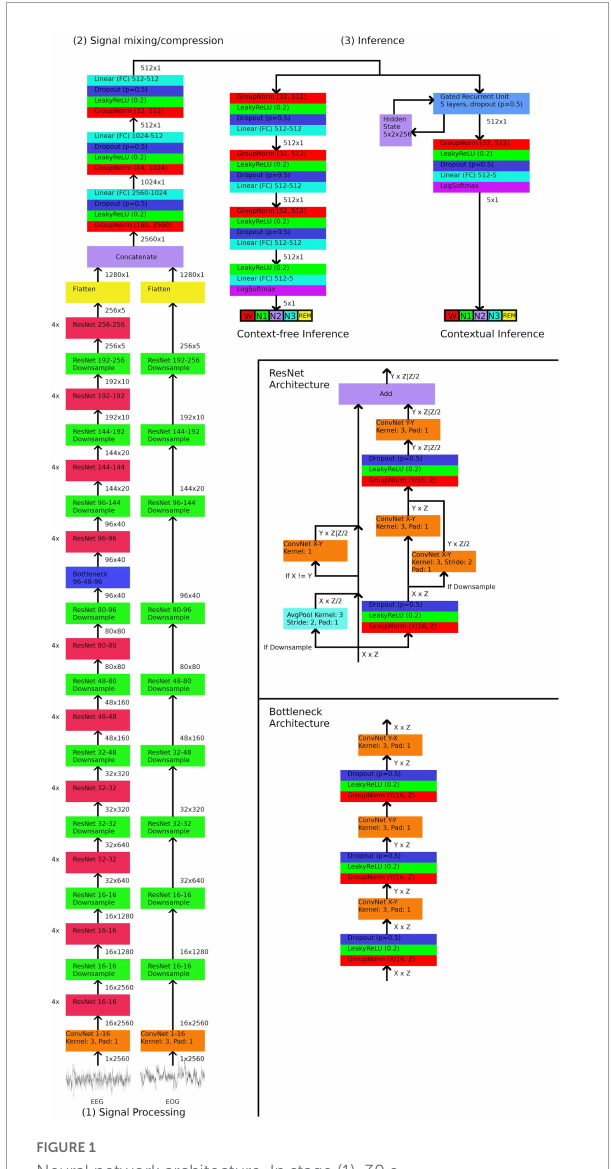
FIGURE1 Neural network architecture. In stage (1), 30 s electroencephalogram (EEG)/ocular (EOG) signals downsampled to a length of 2,560 samples are input through a series of Resnets. The numbers in format X-Y indicate that the ResNet/ConvNet accepts X dimensional filters as input and outputs Y dimensional filters. In stage (2), the output of the ResNets are flattened into one-dimensional vectors, concatenated, and then mixed and compressed by three linear (fully-connected) layers into a vector of length of 512. In stage (3), the 512 length vector is passed onto one of two networks, depending on whether contextual or context-free inference is desired. Context-free inference consists of another three linear layers, and then a final layer which outputs a one-hot vector of length five, which encodes the five sleep stages. Contextual inference inputs the 512 length vector along with a hidden state into a Gated Recurrent Unit, which outputs a 512 length vector and an updated hidden state. A final linear layer outputs a one-hot vector of length five, which encodes the five sleep